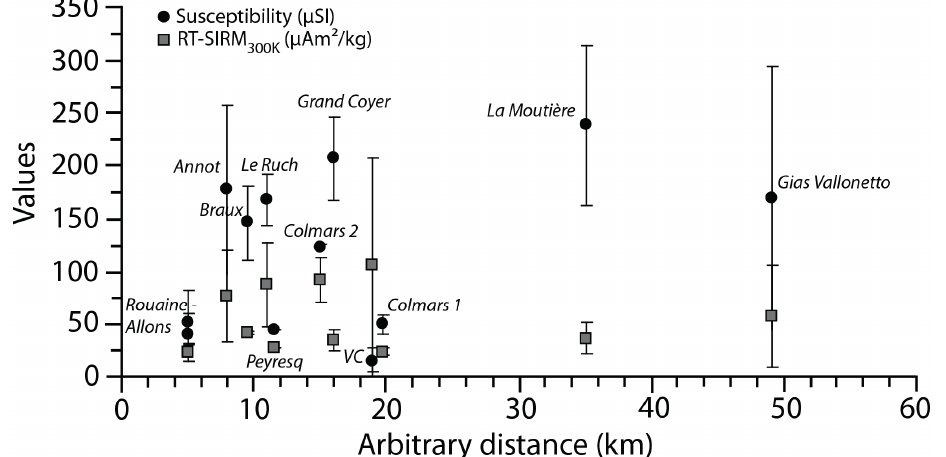
Figure 3. Magnetic susceptibility and saturation isothermal remanent magnetization at room temperature (RT-SIRM ) values along the Grès d’Annot transect. No particular 300 K trend